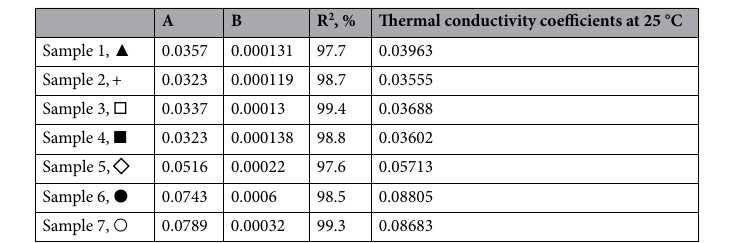
Table 3. Coefficients showing of Eq. (2) and the coefficient of determination for each sample.